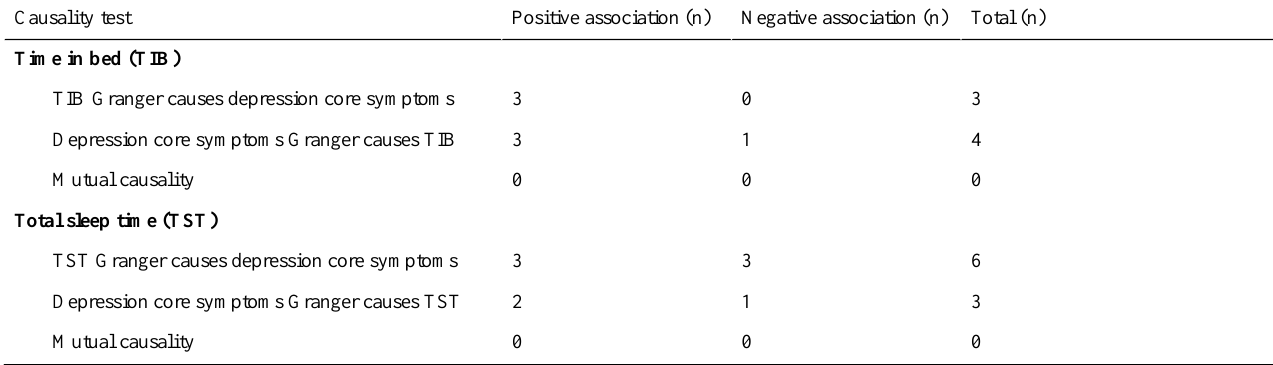
Table 2. Granger causality test results.